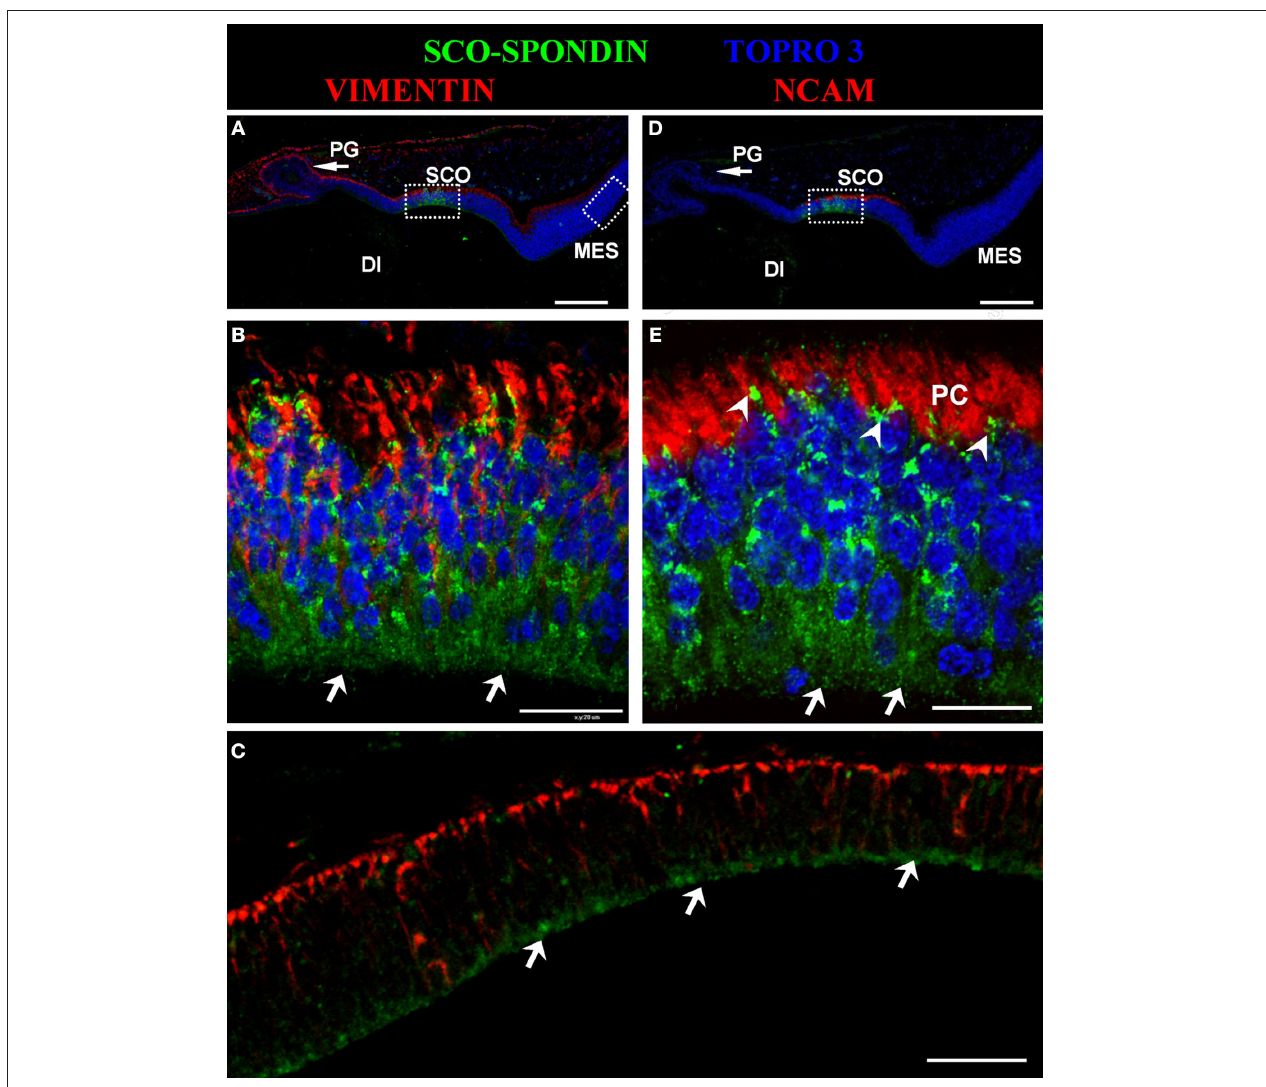
neuroepithelium (arrows in C ). (D–E) Immunohistochemistry with antibodies against SCO-spondin and NCAM counterstained for nuclei with TOPRO-3. (E) Higher magnification of the area boxed in (B) showing the localization of SCO-spondin in contact with the axons of the posterior commissure (arrowheads in E ) and in the apical region of the SCO cells in contact with the eCSF (arrows in B and E ). Di, Diencephalon; Mes, Mesencephalon; PC, Posterior Commissure; PG, Pineal Gland; SCO, subcommissural organ. Scale bars represent 100 μ m in (A,C,D) ; 200 μ m in (B,E)